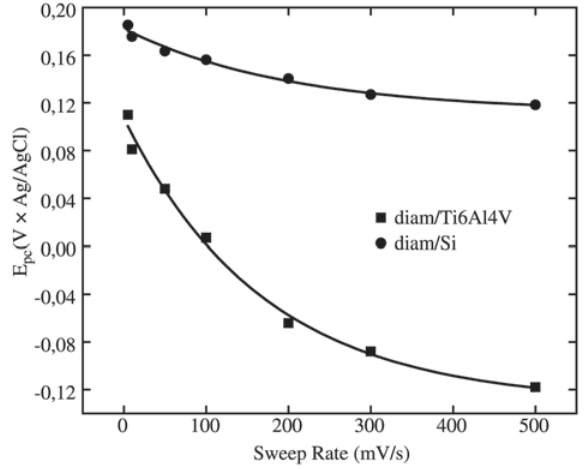
Figure 8. Cathodic potential as a function of sweep rate in 1 mM Ferrocyanide/0,1 M KCl for perforated